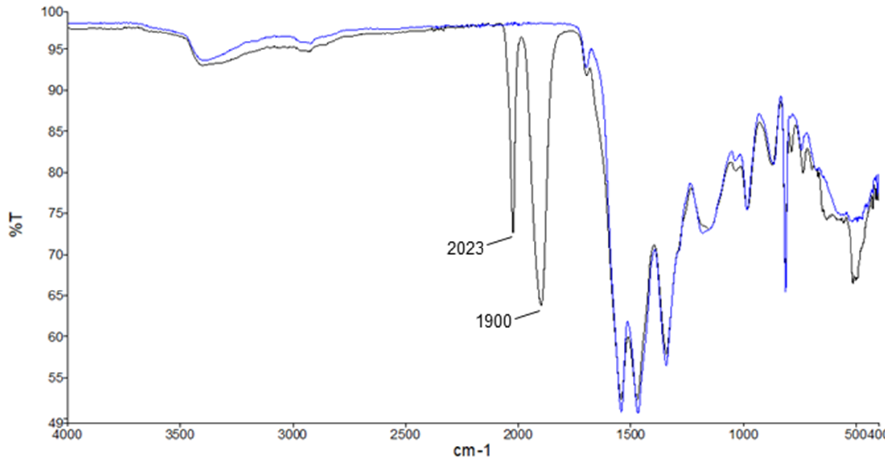
Figure 4. FTIR spectra of POP sample (blue line) and Re@POP (black line). The solid-state 13 C CP/MAS NMR spectra are shown in Supplementary Materials (Figure